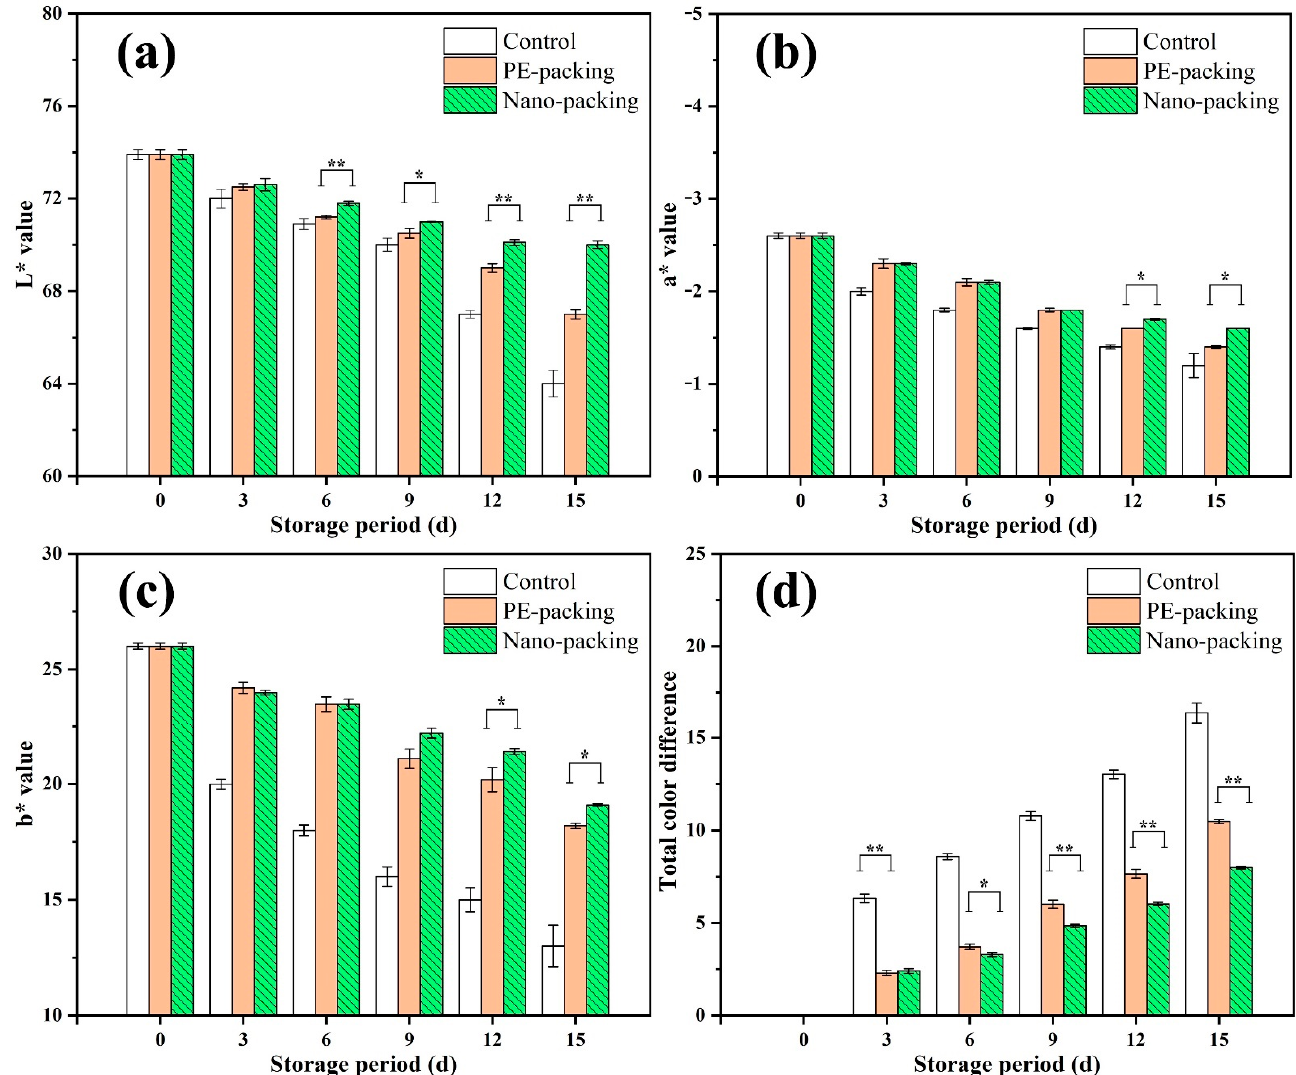
Figure 1. Bar charts of L * ( a ), a * ( b ), b * ( c ) and total color difference ( d ) of mini-Chinese cabbage during storage from 0 to 15 d. * and ** indicate significant difference at p < 0.05 and p < 0.01, respectively. Data are expressed as mean ± standard error.